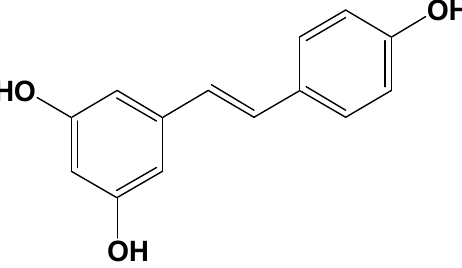
Figure 1. Chemical structure of trans-resveratrol.